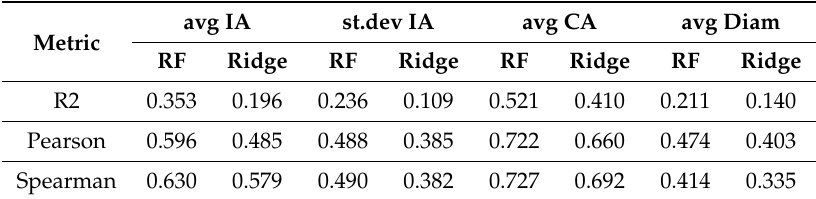
Table 3. Prediction results for spatial community